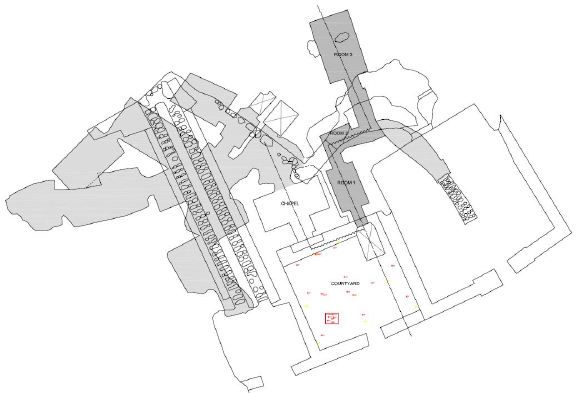
Figure 8 . Plan of TT214.